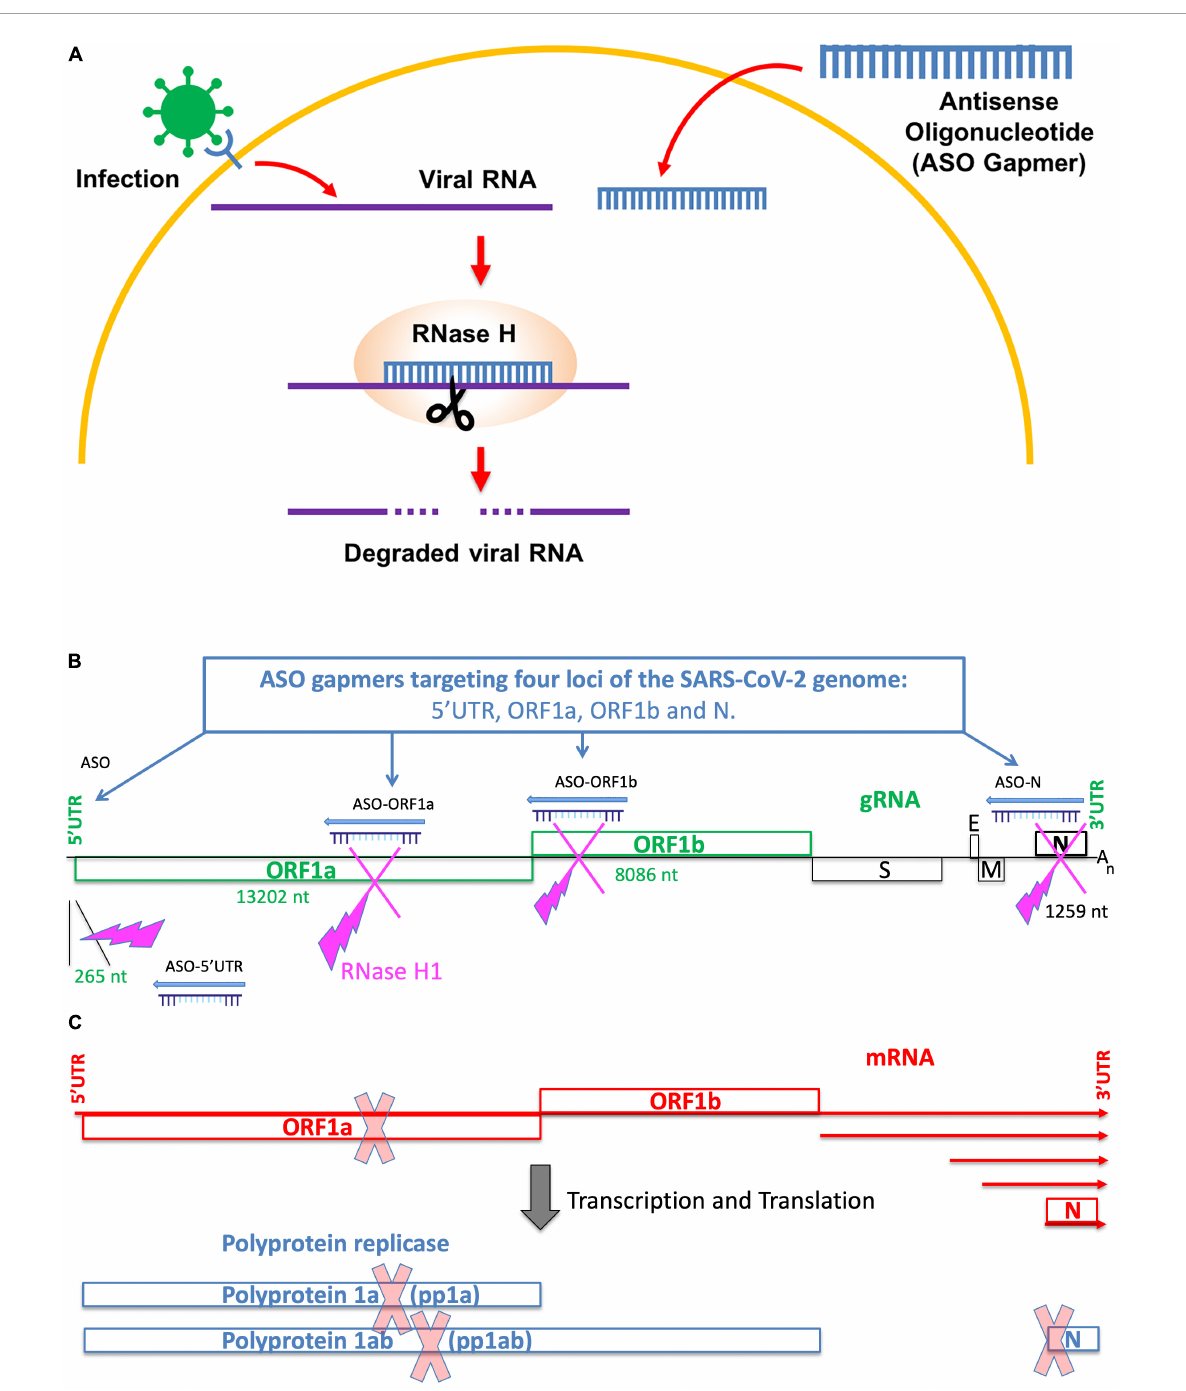
FIGURE1 Antisense oligonucleotide therapy for SARS-CoV-2. (A) Principle of antisense oligonucleotide activity for silencing viral gRNA targets. ASO gapmer enters the cell where it binds to a complementary viral RNA target, which is then cleaved by cellular RNase H. (B) Schematic showing the concept of antisense therapy applied to transcription and replication blockage of the SARS-CoV-2 RNA genome. Genomic sequences and ORFs associated to replication and transcription are indicated in green. The length in nucleotides of each ASO-targeted region is indicated. (C) Schematic showing the viral gRNA and sgRNAs (in red) that share identical 3 (cid:48) sequences and form a 3 (cid:48) nested set of RNAs. The SARS-CoV-2 genome is a positive-sense 29.9-kb RNA molecule (gRNA) that includes a 265-nt-long 5 (cid:48) -untranslated region (5 (cid:48) UTR), followed by 22 kb (ORF1ab) encoding the replication and transcription machineries. The nucleoprotein (N) gene is located at the 3 (cid:48) -end of the genome just before a short 3 (cid:48) UTR sequence. The ORF1ab transcripts are translated into two large replicase polyproteins that are encoded by ORF1a and ORF1b, the latter being translated through ribosomal frameshift. Polyproteins 1a and 1ab are processed and their products constitute the viral replicase and transcriptase machineries, respectively. The N nucleoprotein is encoded by the smallest